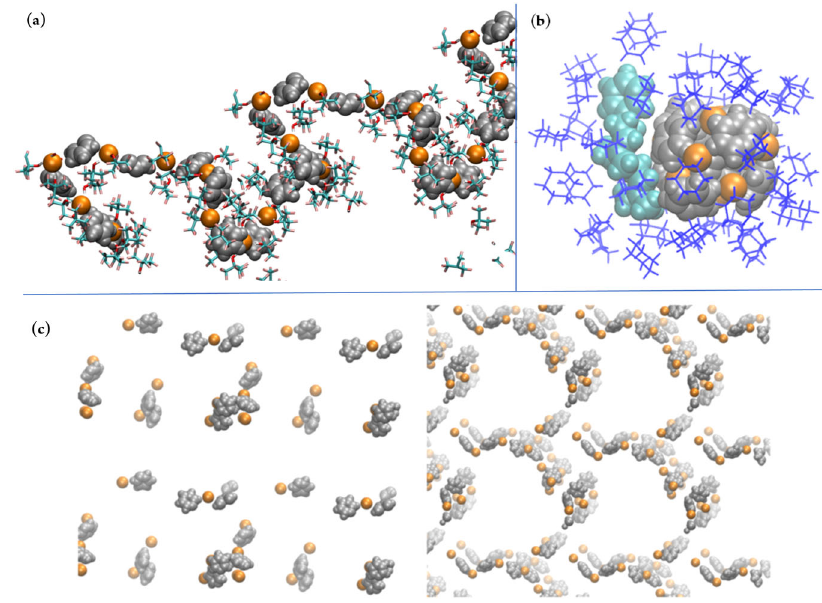
Fig. 4 | Solvent dependent change of ionic aggregation observed in MD simu- lations. Formationofsupramolecularaggregatesin a PFTB( fi rstlayerassticks)and b cyclohexane (blue sticks). In a the polar hydroxyl groups of the immediate PFTB molecules(stick)arefacingthepyridiniumbromideaggregatesandCF 3 groupsthe